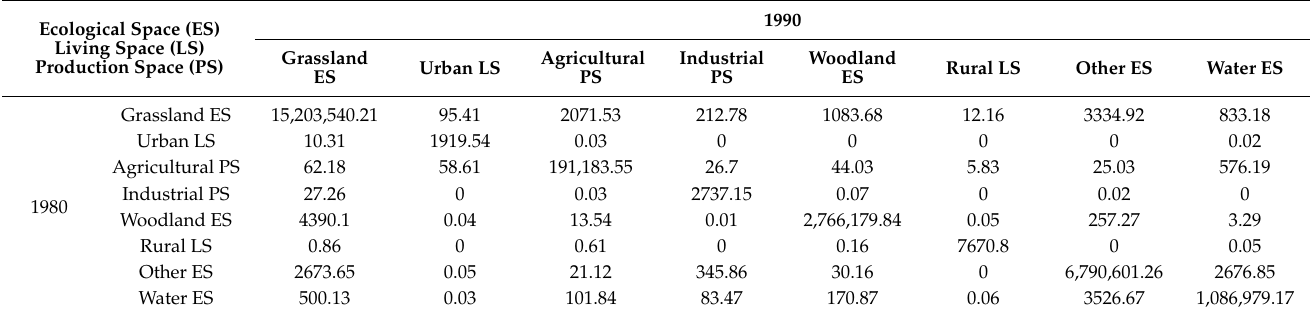
Table A1. Transfer matrix of land use structure change from 1980 to 1990 (km 2 ).